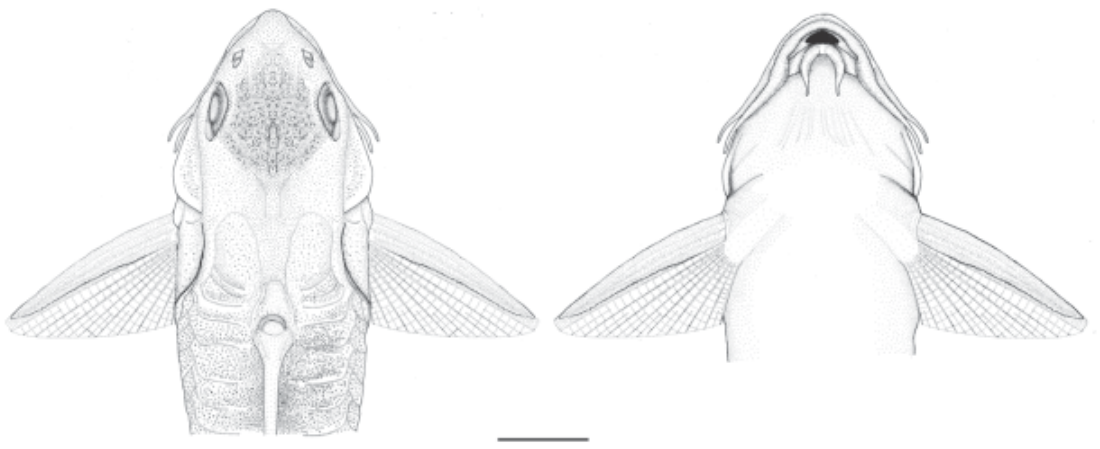
Fig. 4. Dorsal (left) and ventral (right) views of head and pectoral fins of Corydoras tukano , holotype, MZUSP 82100, 40.9 mm SL; Brazil, estado do Amazonas, rio Tiquié, comunidade de